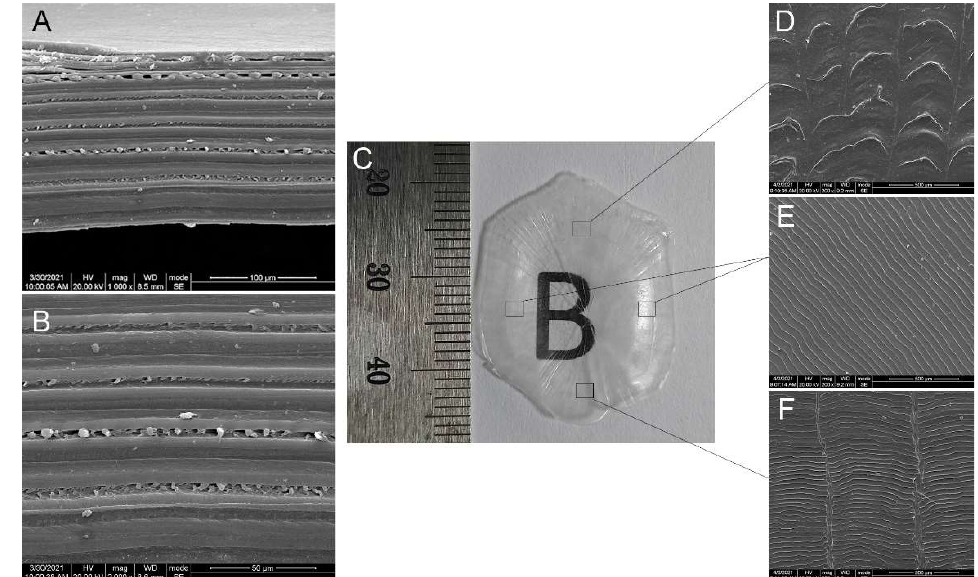
Figure 2. SEM images of surface ( D – F ) and longitudinal section ( A , B ) of FS ( C ).